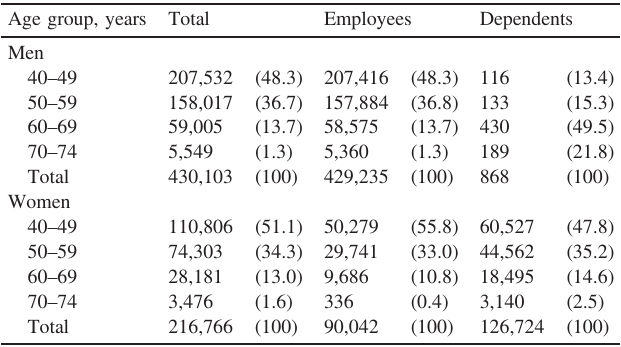
Table 1. Sex and age distributions of the Speci fi c Health Checkup group Age group, years